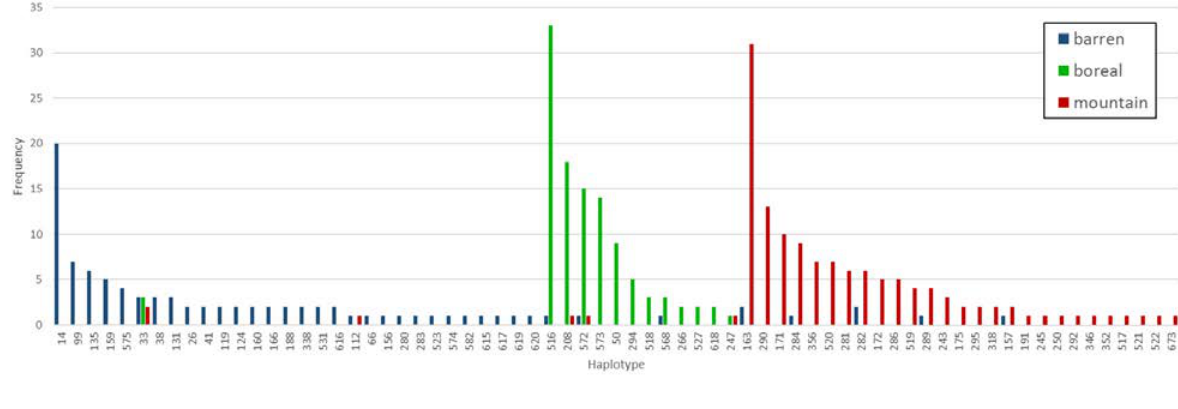
Figure A2.3. Frequency of mtDNA haplotypes for the three major groups identified by structure analysis: 1) barren-ground (blue), 2) boreal woodland (green), and 3) mountain (red). Three haplotypes belong to the North American haplogroup lineage (NAL): 50, 522 and 523, all other haplotypes belong to the Beringian-Eurasian haplogroup lineage